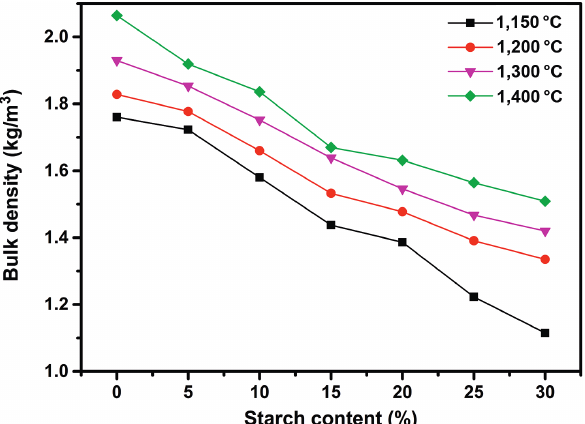
Figure 6: Comparison between bulk density plots of samples with different starch contents.